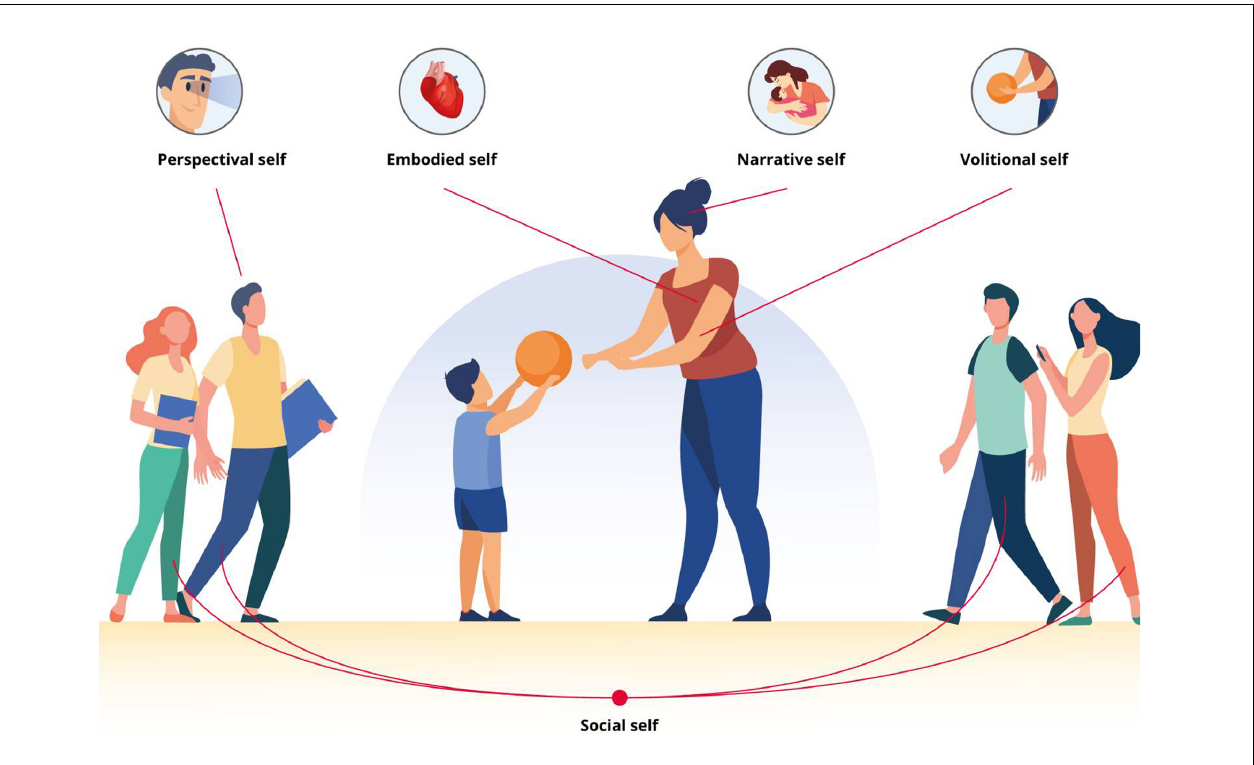
FIGURE 1 | Multilevel representation of human selfhood according to Seth (2021). Embodied self —the sense of having a body, perspectival self —the ability to perceive the world from a first-person perspective, volitional self —the sense of agency, narrative self —the sense of personal identity, social self —linked to the way in which we are perceived by, and interact with